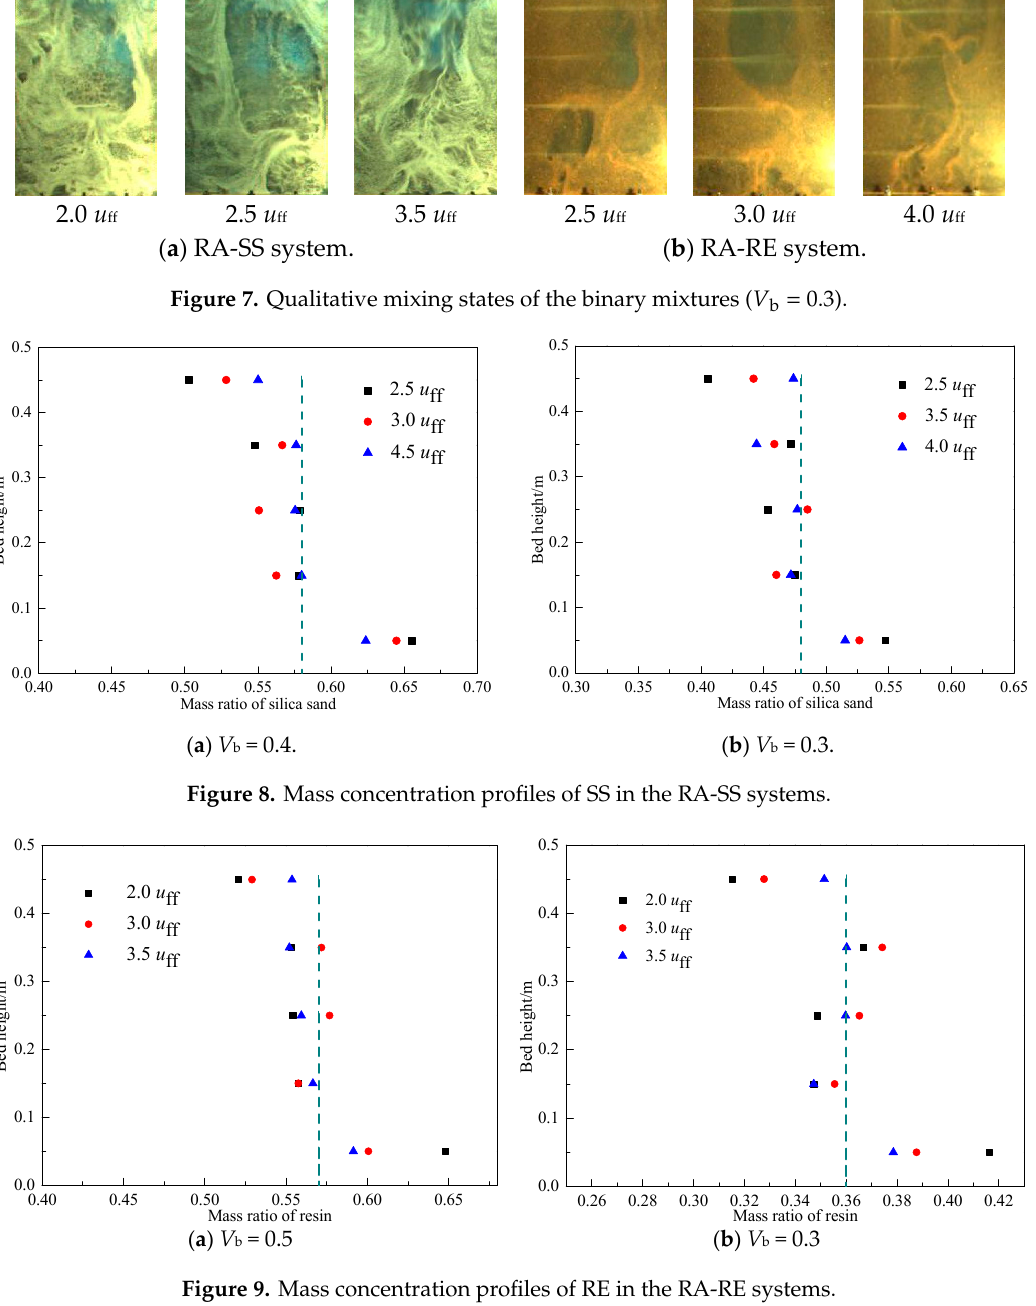
Figure 9. Mass concentration profiles of RE in the RA-RE systems.